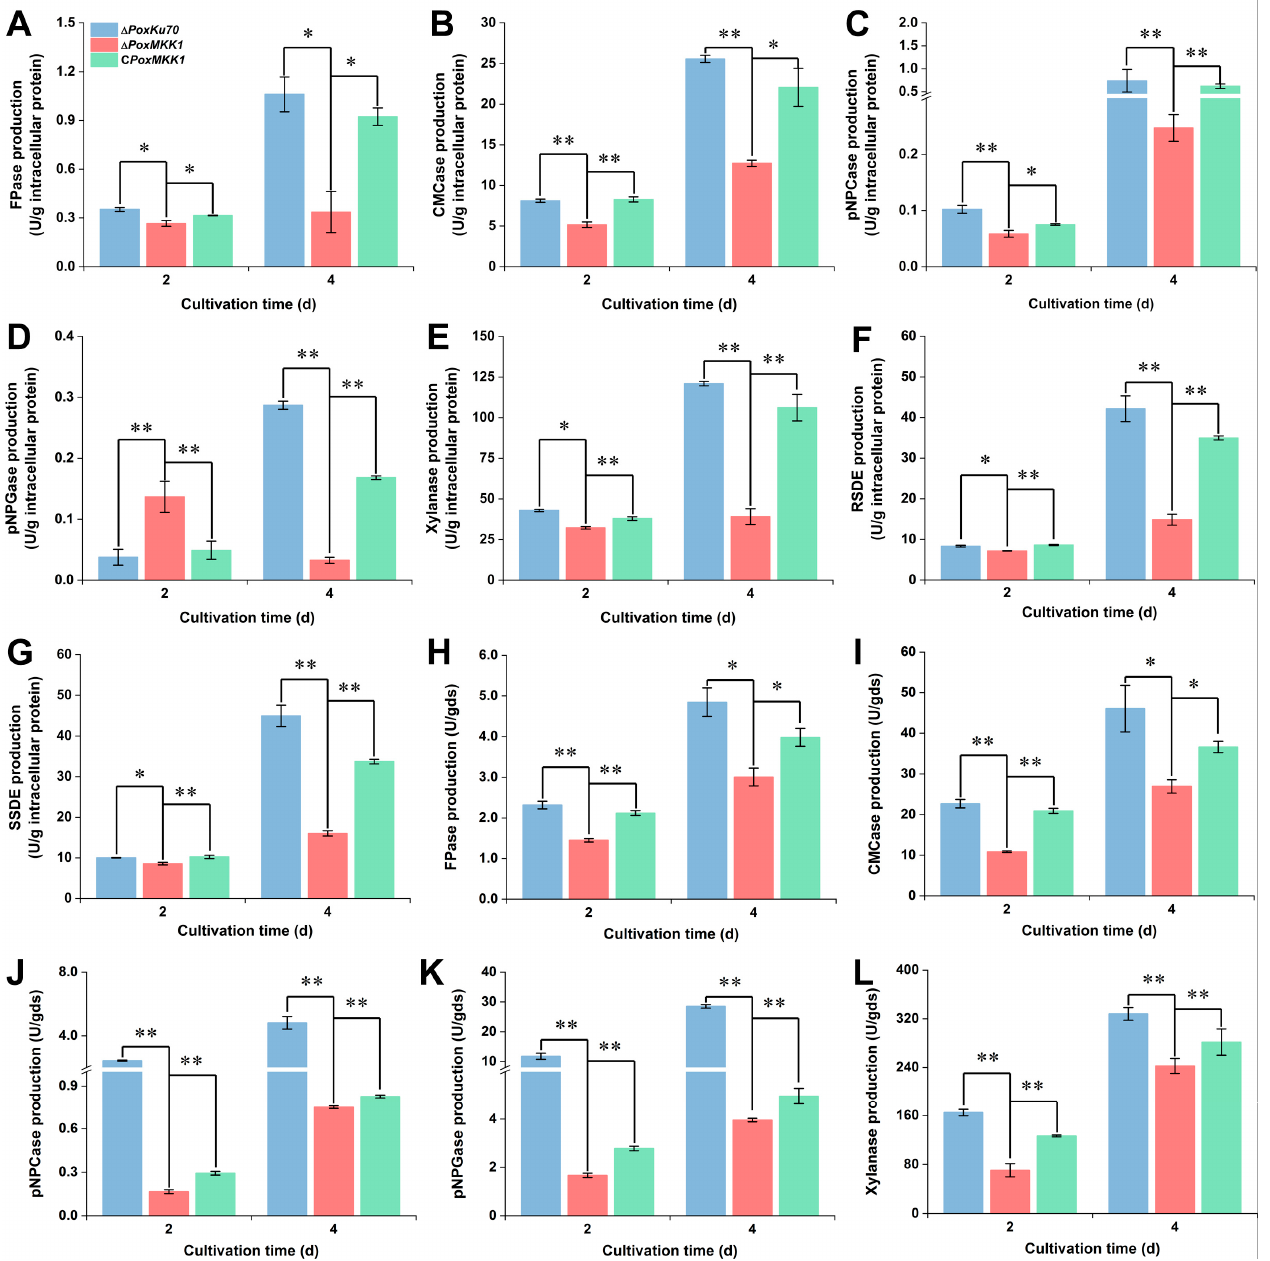
Figure 4. Protein kinase PoxMKK1 affects PPDE production in P. oxalicum . Cellulase ( A − D , H − K ) and xylanase ( E , L ) production are determined in liquid medium with 2.0% Avicel and solid medium containing wheat bran plus rice straw under SmF and SSF, respectively. ( F ) RSDE and ( G ) RSDE. Production was performed in liquid medium with 1.0% SCS. Enzymatic activity was assayed at 2–4 days after a shift from glucose. SSDE, soluble starch-degrading enzyme. RSDE, raw cassava starch-degrading enzyme. SmF, submerged fermentation. SSF, solid-state fermentation. Error bars indicate standard deviations of these results from three biological replicates. Significant differences are indicated by an asterisk between the deletion mutant ∆ PoxMKK1 and the control strain or the complementation strain C PoxMKK1 , respectively (* p < 0.05, ** p < 0.01, Student’s t